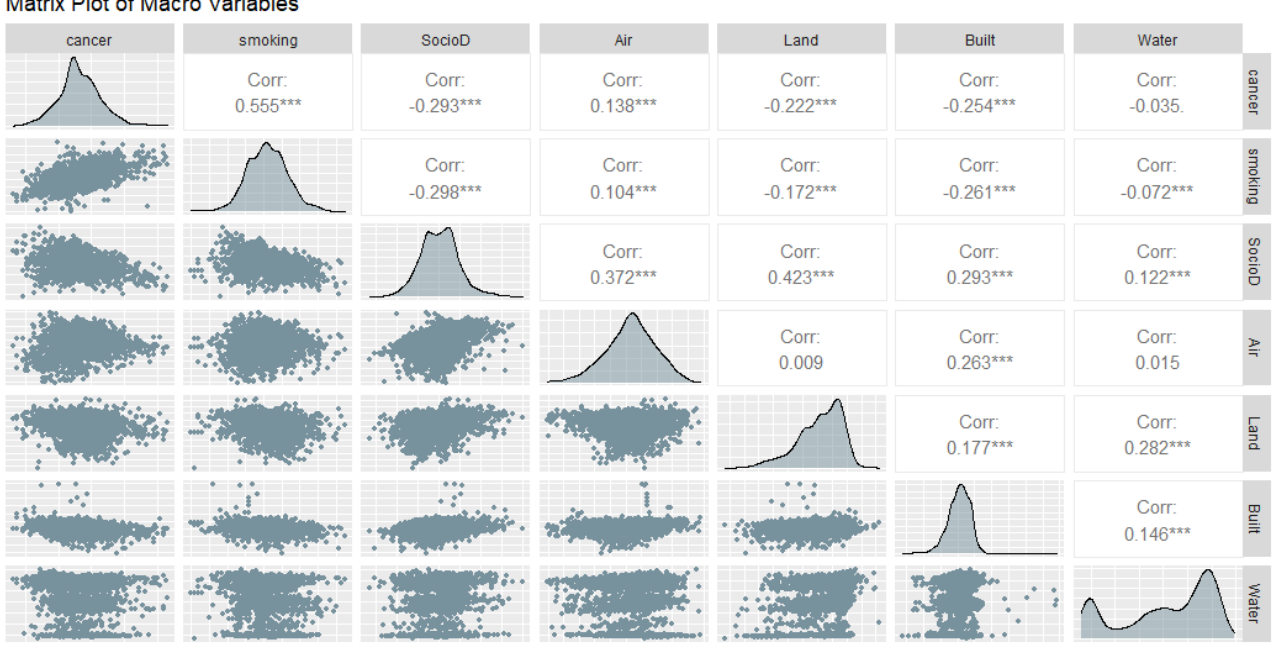
Figure 3. Matrix Plot of Lung Cancer, Adult Smoking, and Environmental Quality Index, all domains. Significance codes: 0 ‘***’ 0.001 ‘**’ 0.01 ‘*’ 0.05 ‘.’ 0.1 ‘ ’ 1.